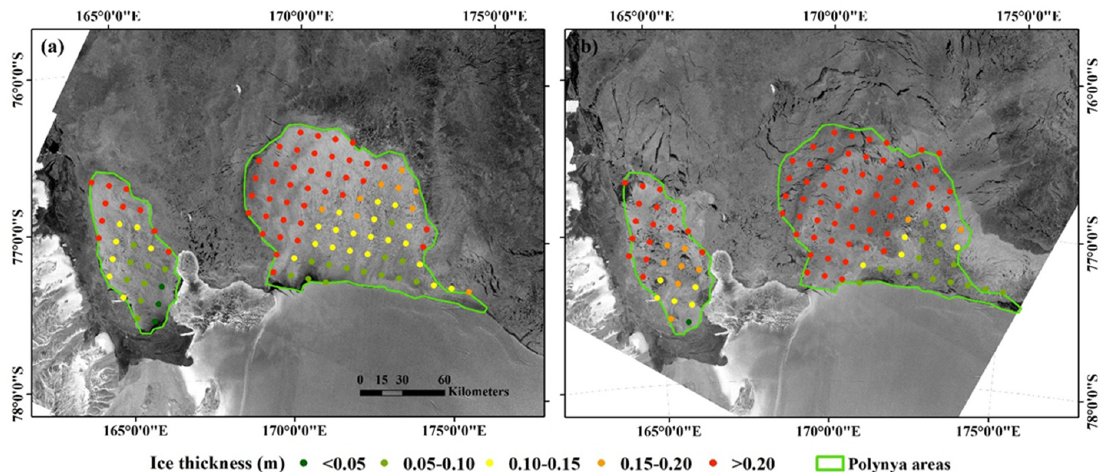
Figure 5. Polynya area (green polygons) mapped from the Sentinel-1 SAR image on 20 August 2017, and the ice thicknesses (dots) within the polynya area derived from AMSR2 on 20 August 2017 ( a ) and 22 August 2017 ( b ).